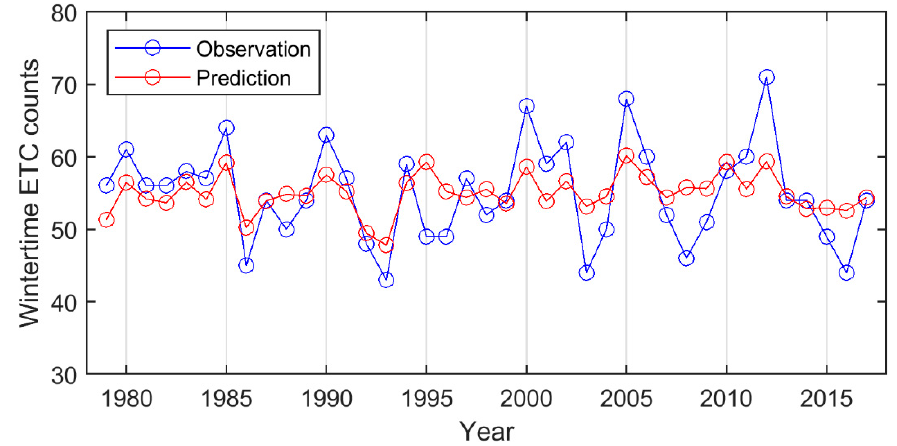
Figure 9. The observations (circle) and predictions (solid) of ETC counts over the Northwest Pacific from 1979 to 2018. Table 2. Cross validation skill scores. The skill scores include MSE, RMSE, and MAE. Methods include BMA and the single best Poisson GLM. A smaller score refers to a procedure resulting in a more accurate prediction.